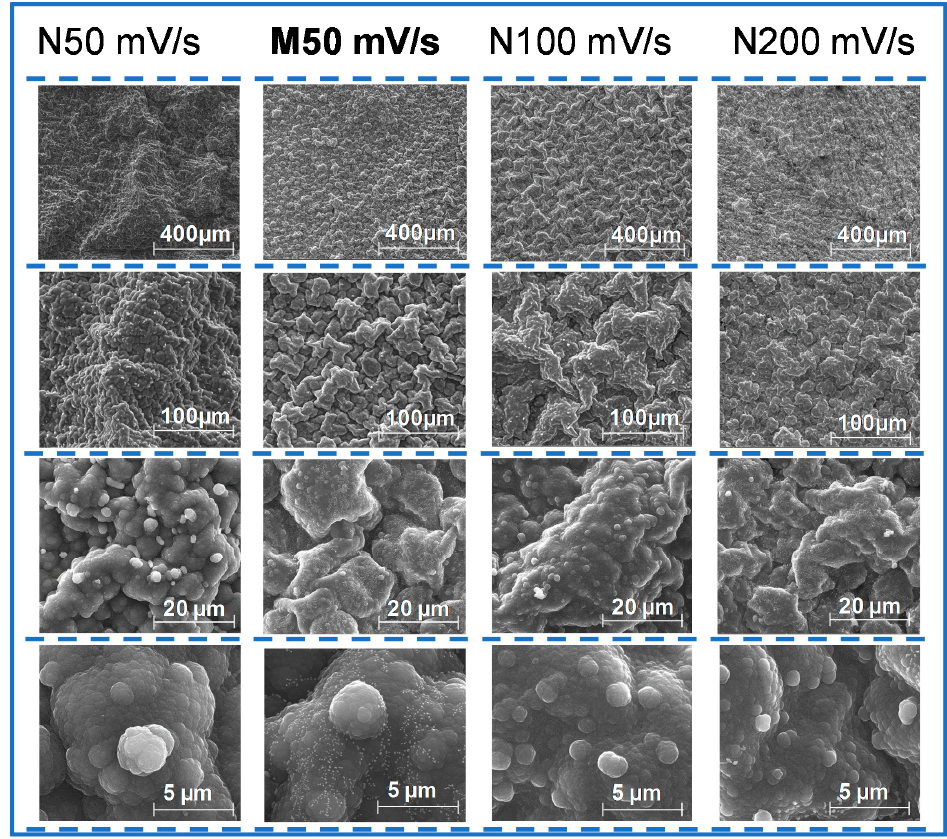
Figure 4. Scanning electron microscope (SEM) images of the PPy MIP materials prepared at a scan-rate of 50 mV/s and PPY NIP materials prepared at 50, 100 and 200 mV/s.